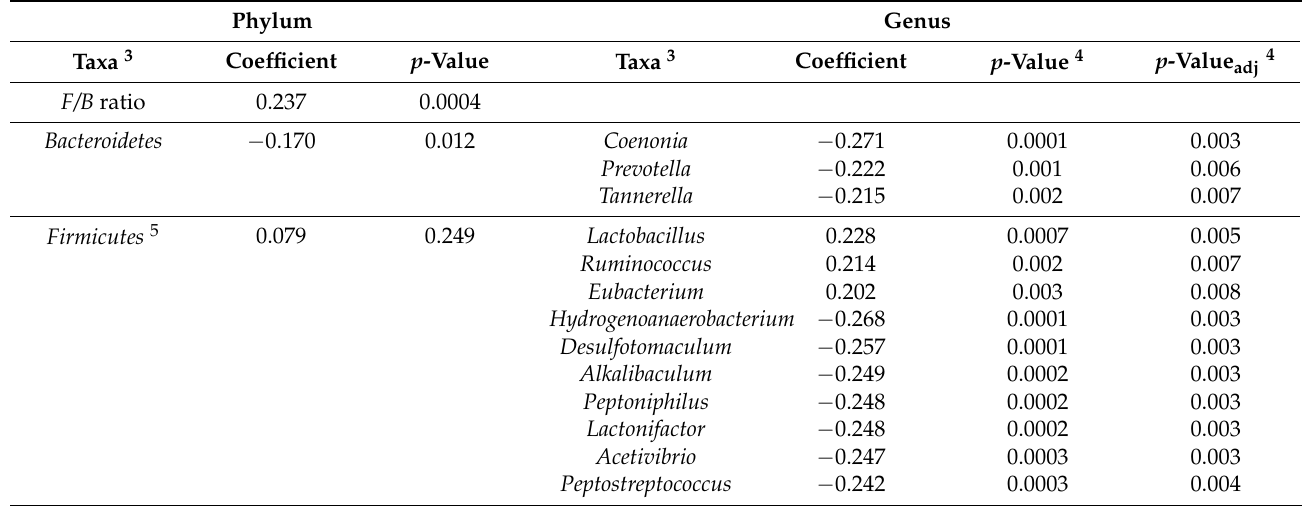
Figure 2. The high α -diversity dietary pattern (Hi α DP) in Korean adults of the NAS-IARC cross-sectional study ( n = 222 participants). The factor loading of each food group of the Hi α DP in the Korean adults was estimated in a Reduced Rank Regression (RRR) model with the intake of 25 food groups as predictor variables and the Shannon index ( α -diversity index) as a response variable; the Shannon index was log-transformed and the intakes of food groups were log-transformed and adjusted for total energy intake using the residual method. Table 2. Spearman correlations 1 between the high α -diversity dietary pattern (Hi α DP) 2 and relative abundance (% operational taxonomic units (OTU)) of gut microbiota at the phylum and genus levels in Korean adults of the NAS-IARC cross-sectional study ( n = 222 participants).